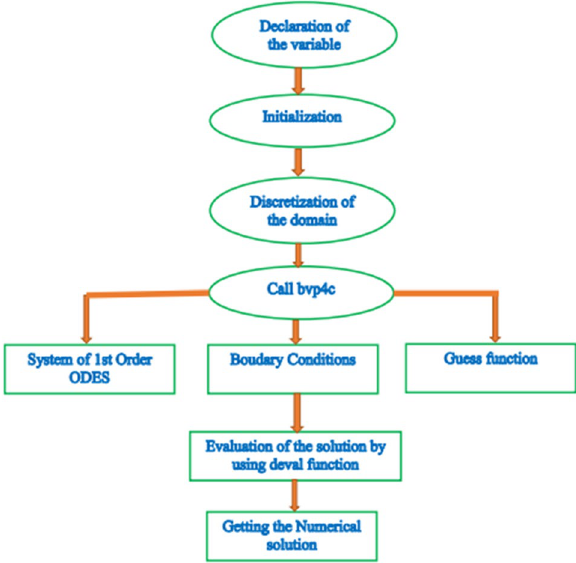
Figure 2. The flow chart of the numerical